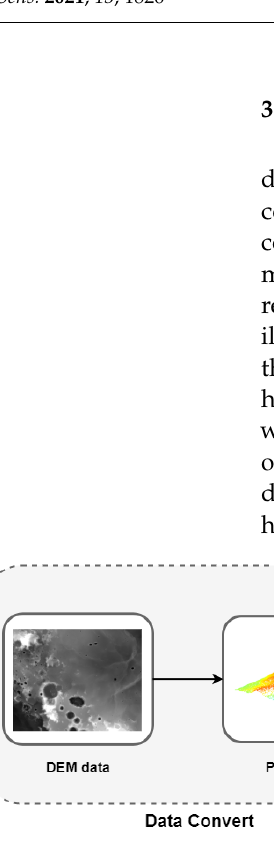
Figure 1. Illustration of overall framework of the proposed method. The pre-detection module takes the point cloud data transformed from DEM data as input, and outputs the preliminary prediction results. Next, the preliminary detection results are refined in the post-processing